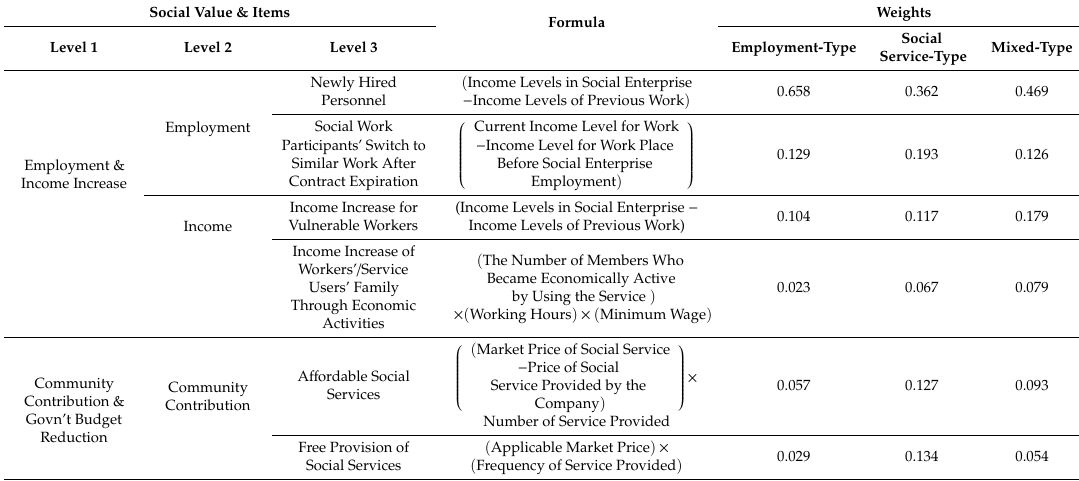
Table 5. Diagnostic Kit on Management by Type of Social